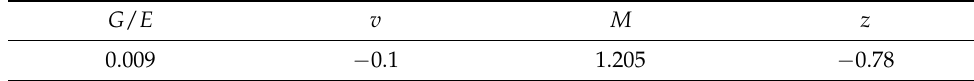
Table 7. Parameters of fatigue models for P91